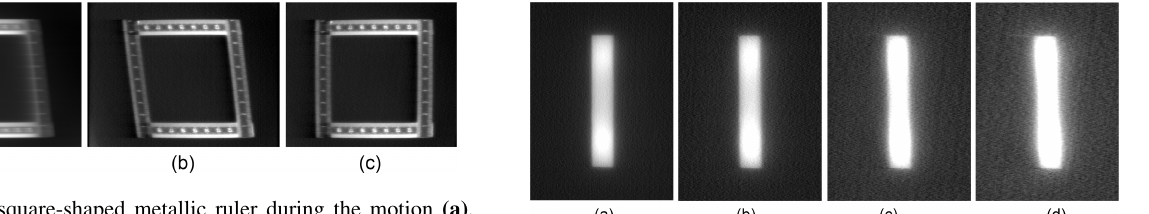
Figure 9. A square-shaped metallic ruler during the motion (a) , the deblurred image (b) and the deblurred image applying also the shearing transformation of Eq. (17) (c) . Figure 10. Restored images of Fig. 2 moving a small plate with